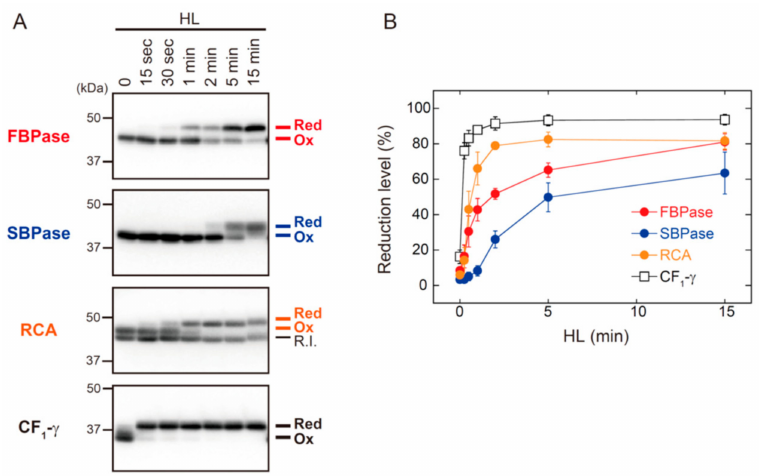
Figure 3. The in vivo redox responses of Trx-targeted proteins in Arabidopsis . Dark-adapted plants were placed under HL conditions (650–700 µ mol photons m − 2 s − 1 ) for the indicated time period. ( A ) The redox state of FBPase, SBPase, RCA, and ATP synthase CF 1 - γ subunit was determined as previously described [19]. Red, reduced form; R.I., redox-insensitive form of RCA; Ox, oxidized form. ( B ) The reduction level of each protein was calculated as the ratio of the reduced form to the total. Values represent the mean ± SD ( n =